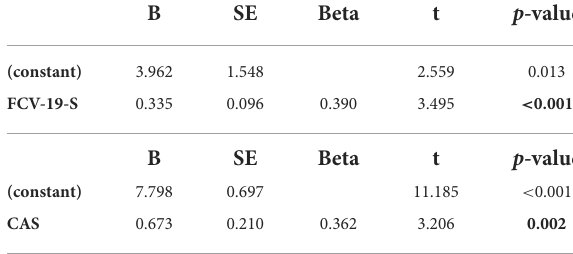
TABLE 5 Linear regression